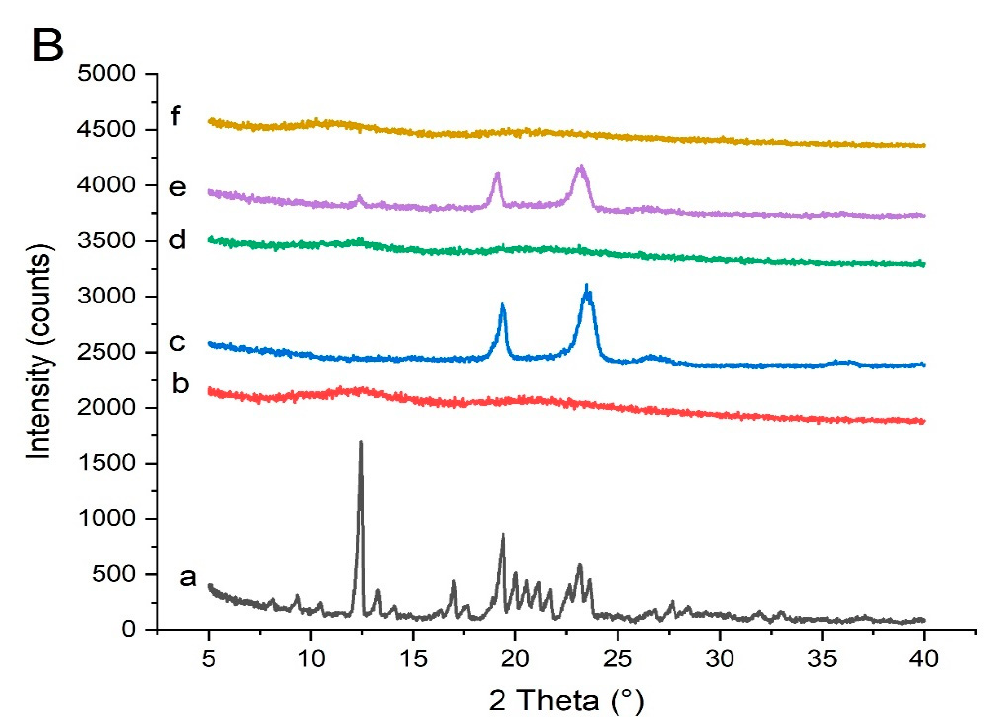
Figure 9. PXRD data of ( A ) Irbesartan and binary solid dispersions: (a) pure Irbesartan, (b) Kollidon ® VA 64, (c) binary solid dispersion of drug and Kollidon ® VA 64 at ratio 1:4 [K 4 ], (d) Soluplus ® , (e) binary dispersion of drug and Soluplus ® at ratio 1:1 [S 1 ]. ( B ) Irbesartan and ternary solid dispersions: (a) pure Irbesartan, (b) Kollidon ® VA 64, (c) Kolliphor ® P 407, (d) Polyvinylpyrrolide- K30, (e) ternary solid dispersion KP407 (TD 3 ), (f) ternary solid dispersion KPVP (TD 3 ).